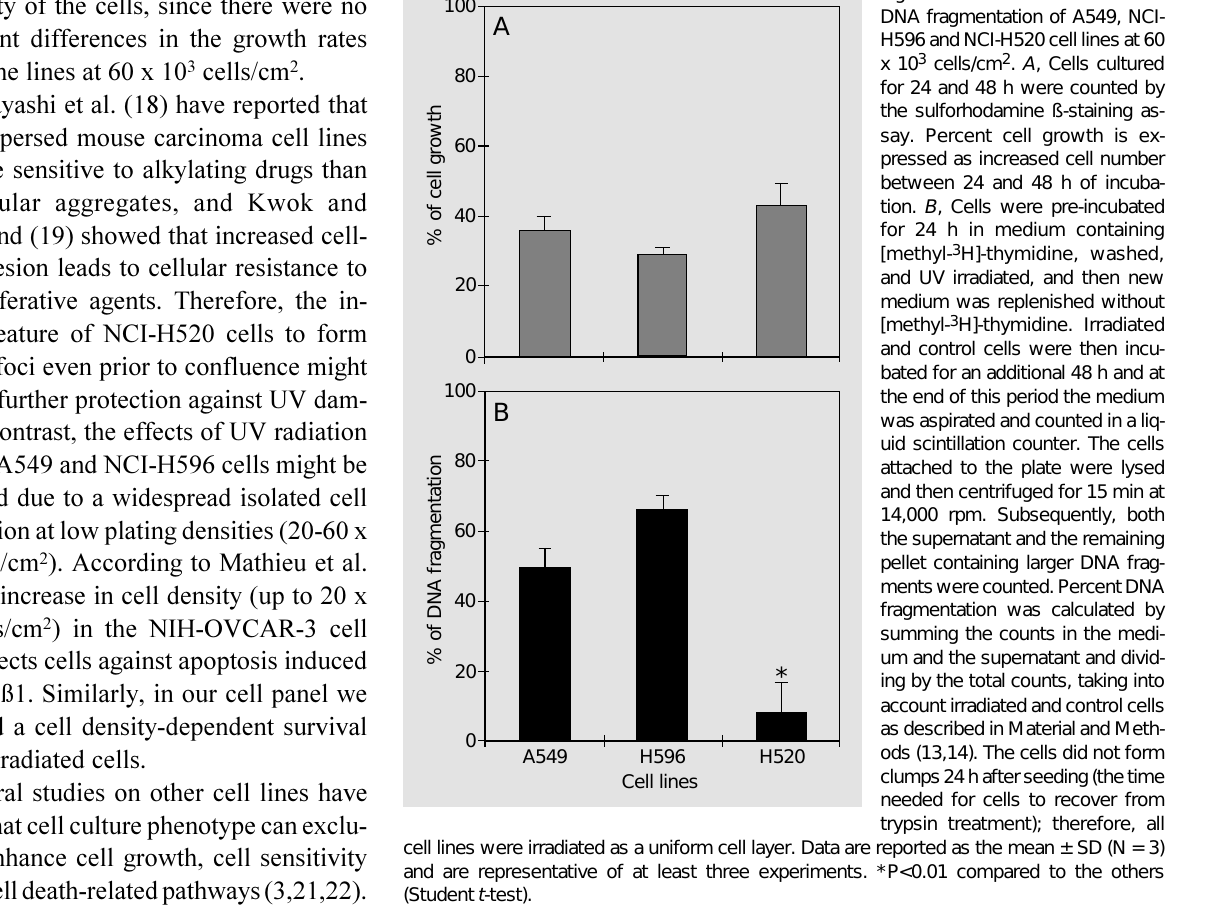
growth was inhibited by 70%) (8,12). All cell lines at each density tested were irradiated as a uniform cell layer, since the confluent cells did not form clumps 24 h after seeding (the time needed for cells to recover from trypsin treatment). Data are reported as the mean ± SD of five independent determinations at each cell density (N = 6). *P<0.05 and **P<0.01 com- pared to the others (Student t-